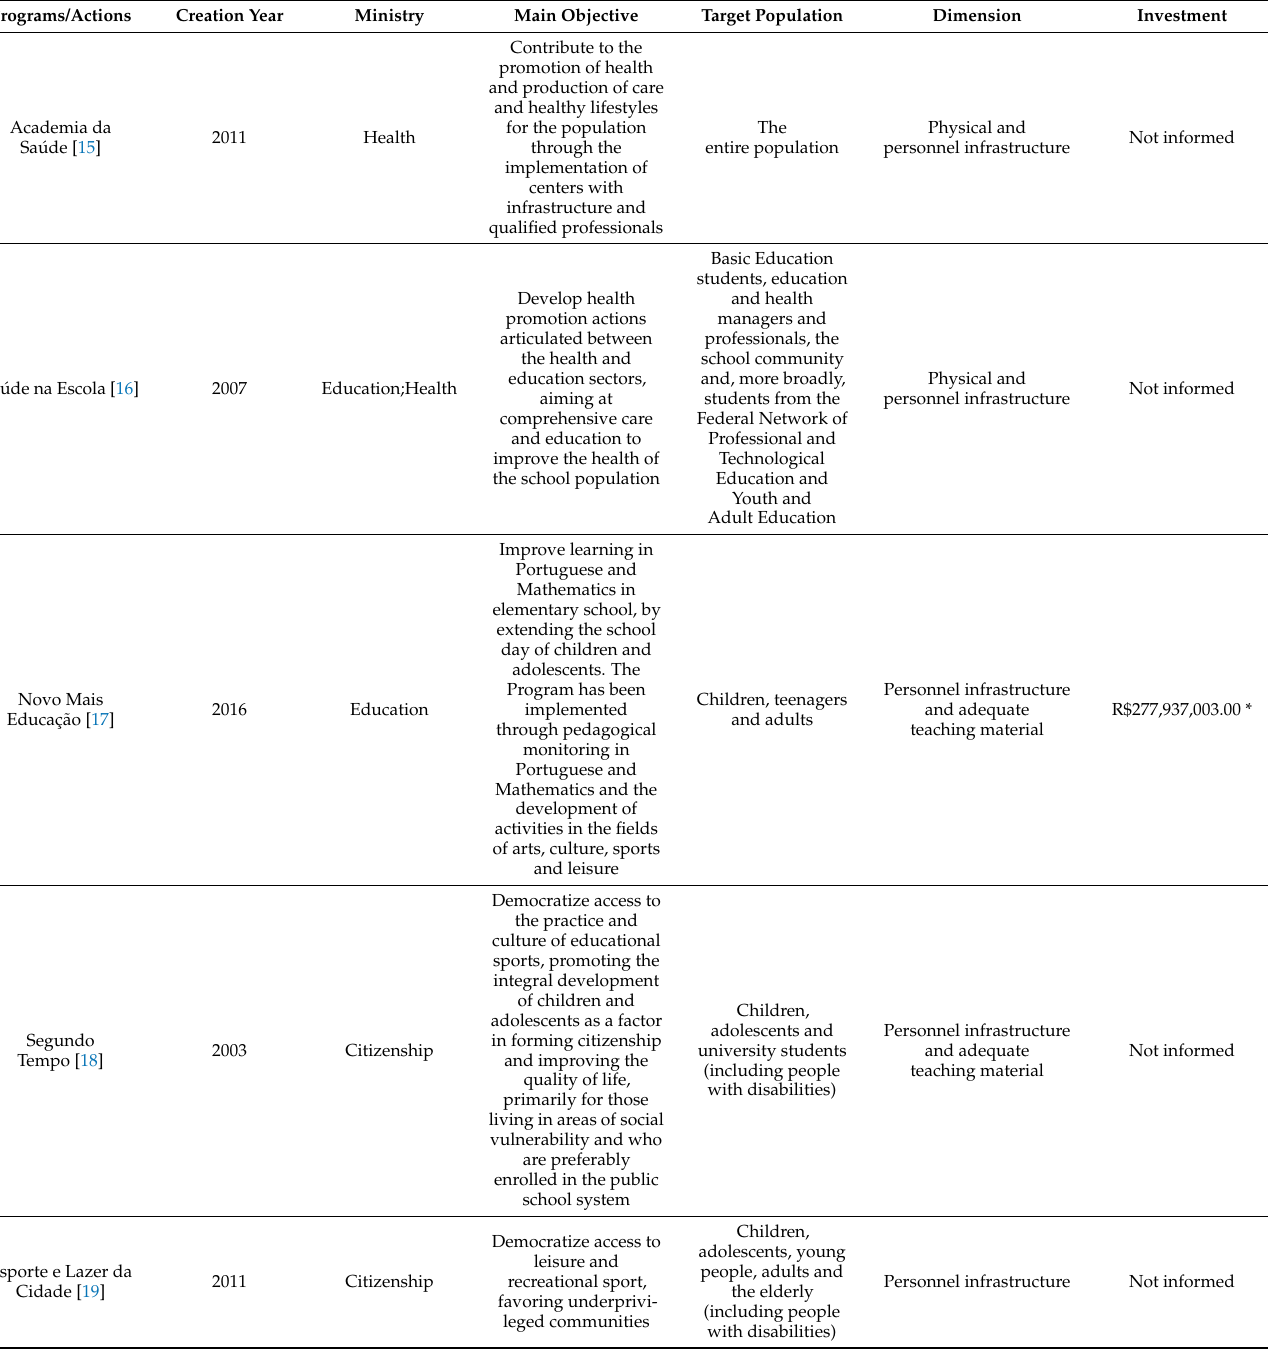
Table 1. Programs/Actions for the promotion of physical activity for children and adolescents in